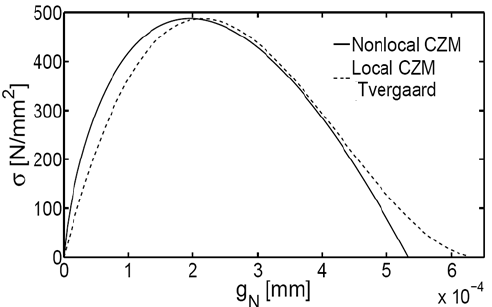
Figure 8: Shape of the nonlocal CZM (average curve) used for the fracture simulations and that of the Tvergaard [9] model with the same average fracture